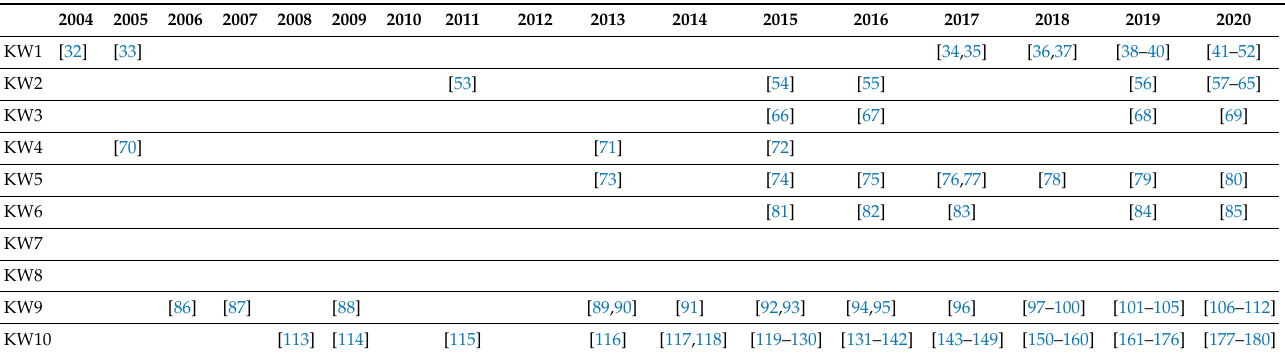
Table 5. Distribution of eligible articles based on search keywords.